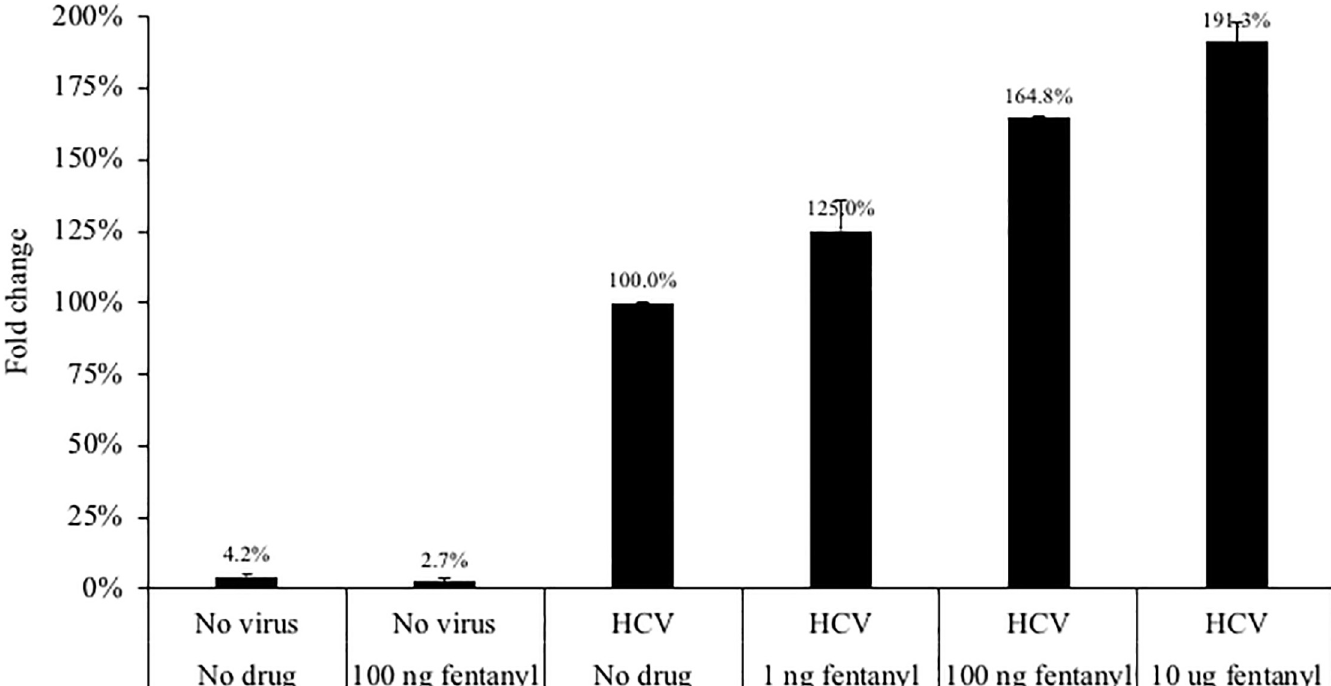
Fig 3. The parental Huh7.5 hepatocyte cell line was seeded at 500,000 cells per well. Infectious HCV (the JFH1 isolate from the Huh7.5 JFH1 cell line) was added at TCID 50 of 0.5 for 1 hour. Fentanyl was added to culture medium. After 24 hours of incubation with drug, HCV core protein (ng/mL) was quantified in culture supernatants. ANOVA for dose effect: p < 0.0001.